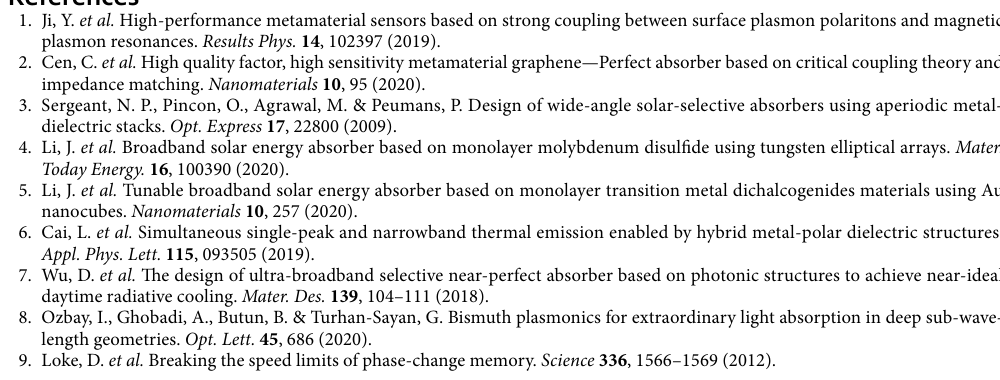
of the absorption and the phase change of the chalcogenide allows it to be used as a semiconductor and insula- tor, and this reconfigurability modify the concentration of the electromagnetic fields, displacing the structure’s resonance peaks to others regions. We would consider the use of approaches based on neuromorphic systems in future proposals 54 . This structure can be an alternative solution for absorbers with potential applications for various technologies employed in reconfigurable nanophotonic devices.